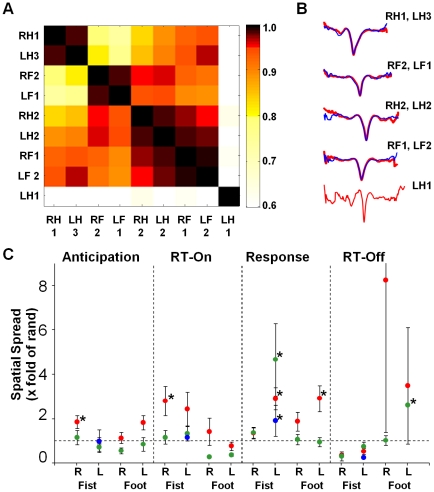
Fine Scale Temporal Structure of Coherence Potentials.(A) Correlations of the average nLFP waveform of each of nine clusters (9×9 matrix). Clusters RH1 (right fist clenching) and LH3 (left fist clenching) are highly similar as are clusters RF2 (right foot dorsiflexion) and LF1 (left foot dorsiflexion) but more distinct from one another. Clusters RH2, LH2, RF1 and LF2 are more similar to eachother. LH1 is distinct from the others. (B) Average waveforms compared in A. (C) Behaviorally relevant (i.e. trial associated) coherence potential waveforms have greater spatial spread than non-relevant waveforms. Spread within 10 ms after occurrence of an nLFP on electrodes 27 and 28 within each trial-spanning cluster normalized by the spread of other coherence potentials in the same interval that were not trial-spanning. The waveform of cluster RH1 (right fist clenching) had significantly greater spread in the anticipation and RT-ON intervals while clusters in the left fist clenching and left foot dorsiflexion had significantly greater spread in the response interval.